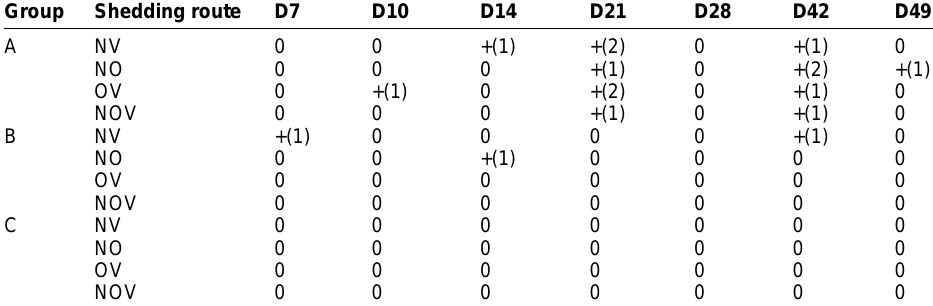
Table-2. Comparison of the relationship between the 3 shedding